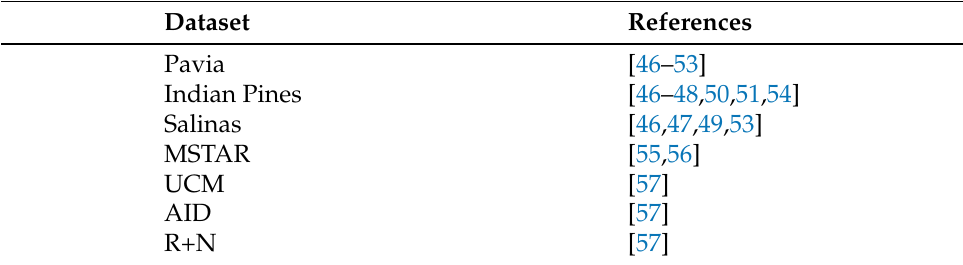
Table 3. The datasets for remote sensing classification reported in the primary